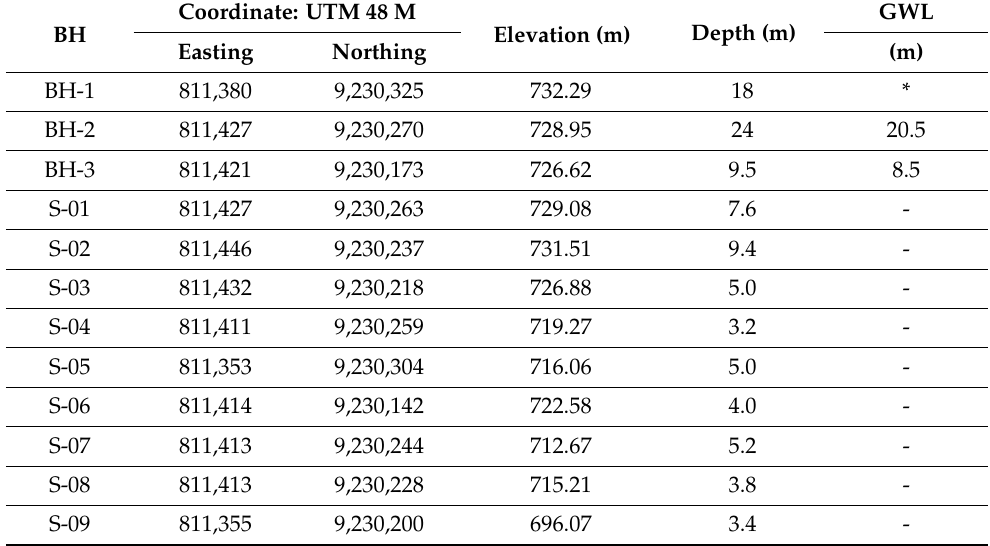
Table 1. Boreholes and CPT